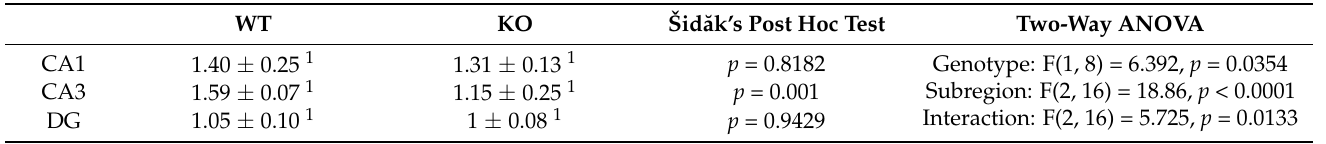
Table 7. Results of two-way ANOVA tests for the effects of the genotype and hippocampal subregion on the relative immunoreactivity for SREBP-1 in WT and KO mice ( n = 5